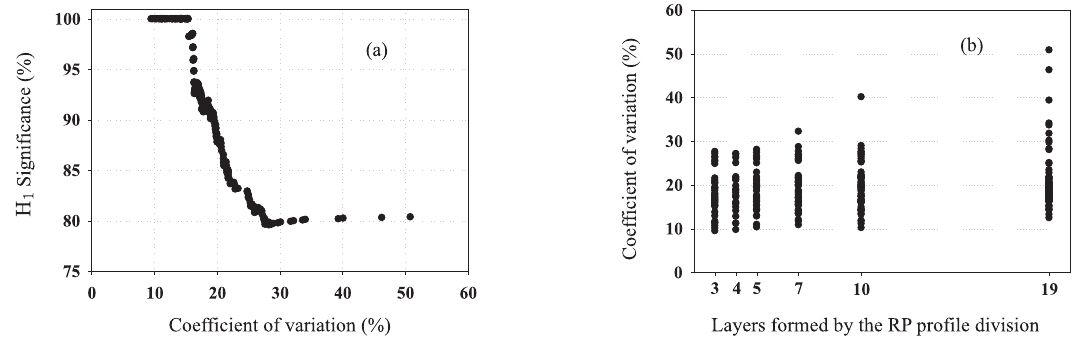
Figure 3. Relationship between the coefficient of variation and the significance of the hypothesis of differences in penetration resistance (H ) between compaction levels (a) and the effect of PR profile 1 division on the coefficient of variation